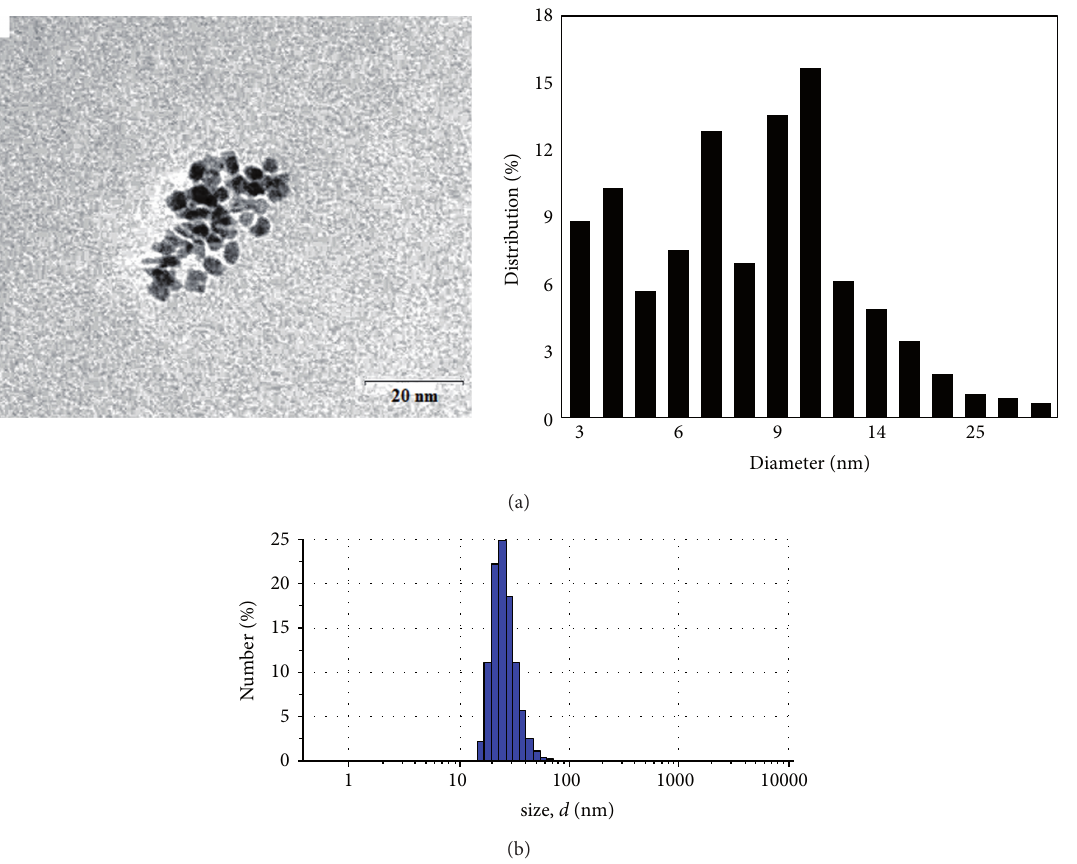
F 4: (a) TEM image and number distribution and (b) DLS distribution of Ru nanoparticles using SDS using particle-size